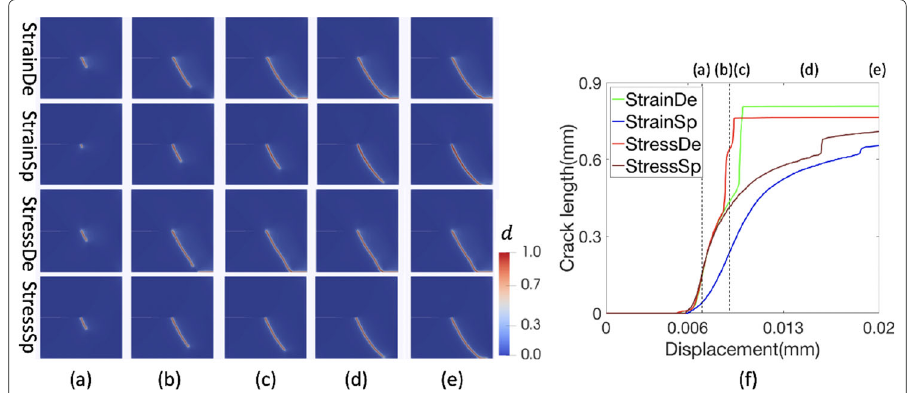
Fig. 8 Fracture results from the single edge notched shear test: ( a ) - ( e ) crack paths at u = 0.007 mm, u = 0.009 mm, u = 0.010 mm, u = 0.015 mm, and u = 0.020 mm, respectively; ( f ) crack length evolution for the four methods, with the displacements from ( a ) - ( e ) marked with dashed